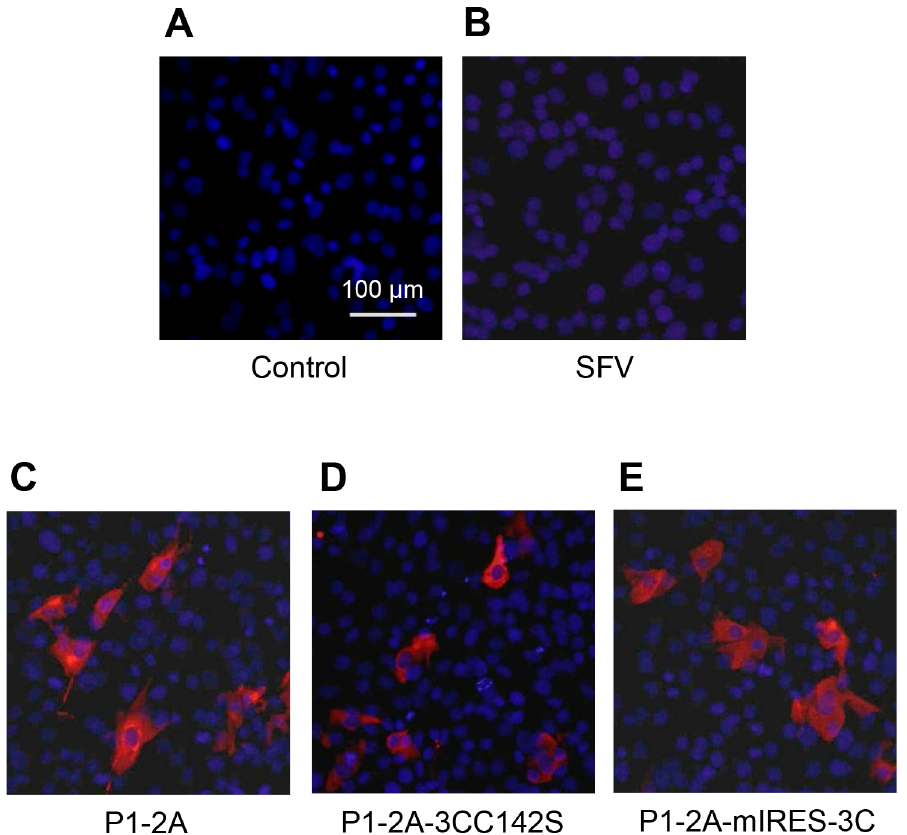
Fig 2. Expression of FMDV capsid proteins using the SFV split-helper system. Uninfected BHK cells (A) or cells infected with rSFV (B), rSFV-FMDV-P1-2A (C), rSFV-FMDV-P1-2A-3CC142S (D) or rSFV-FMDV-P1- 2A-mIRES-3C (E), at an MOI of 20, were immunostained at 16 h post infection. FMDV proteins were detected with an anti-FMDV O1 Manisa polyclonal antibody and a secondary antibody labeled with Alexa Fluor 568 (red). The cellular nuclei were visualized with DAPI (blue). Bar, 100 μ m. The results shown are representative of three independent